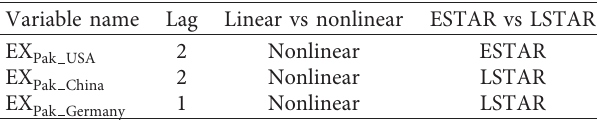
Table 3: Linear vs nonlinear behavior of exchange rates.